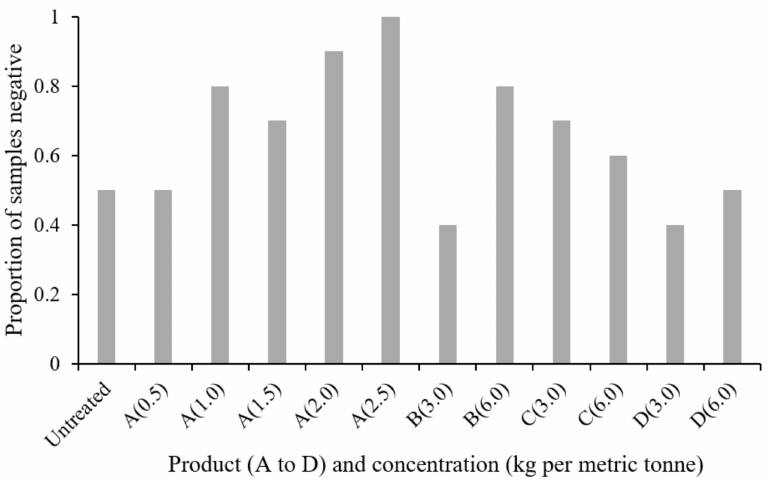
Figure 3. Proportion of samples negative for E. coli following 24 h contact with feed treated with each of the